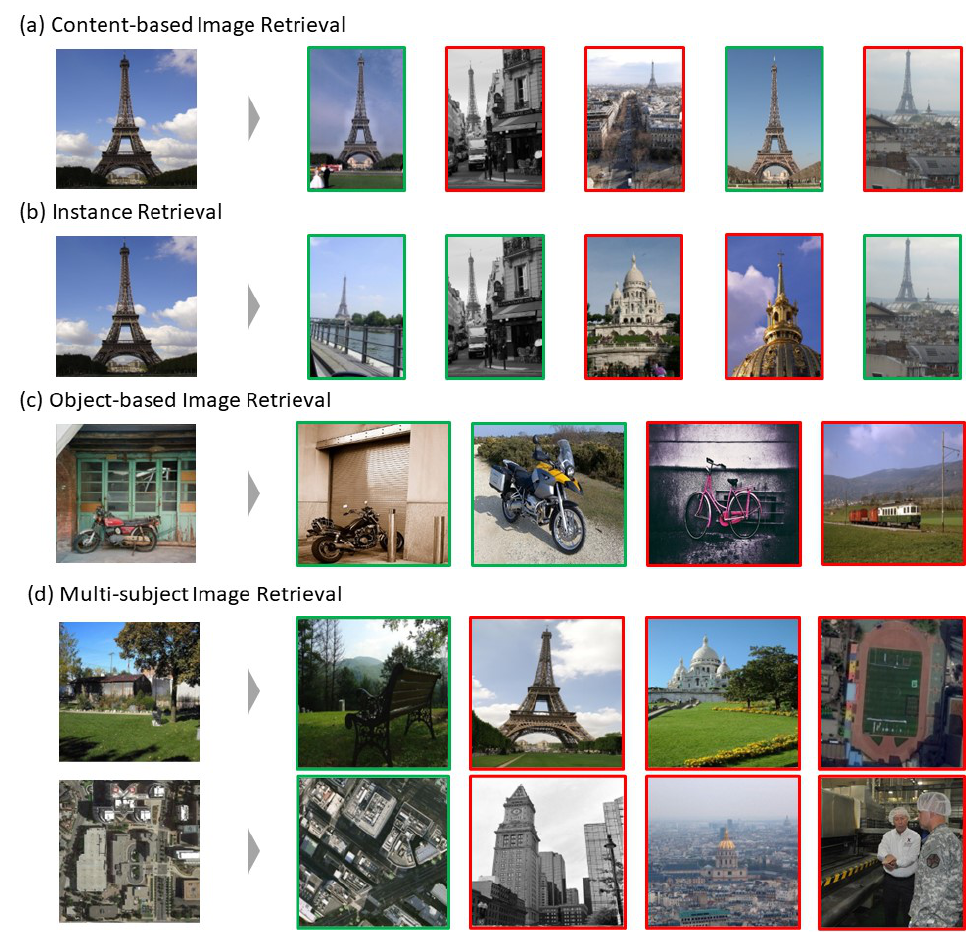
Figure 1. The example of single-subject and multi-subject image retrieval. The image on the left is the query image and the image on the right side of the arrow is the retrieved image. The green box means that it is the right image for the purpose of the search. The red box means that the image is not suitable for search purposes. Contrary to single-subject image retrieval that searches a single topic such as content, instance, and object at once, multi-subject image retrieval deals with multiple topics in the same